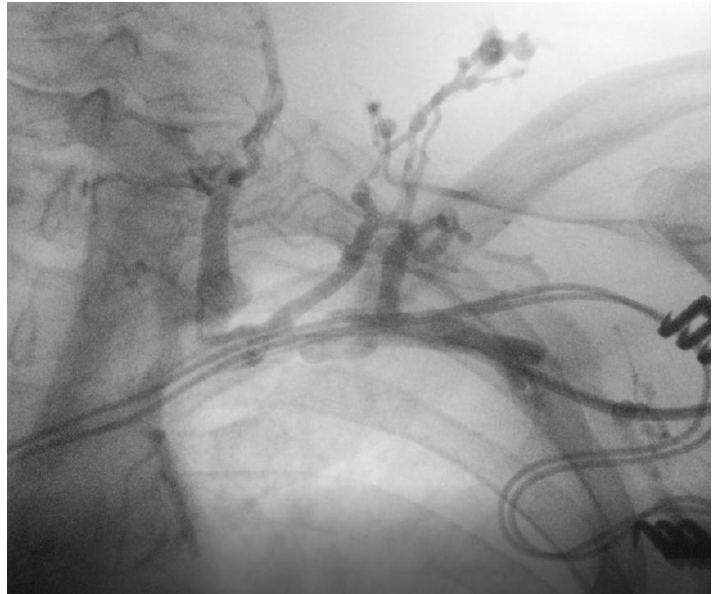
Figure 5. Occlusion of the left subclavian vein, with collateral circulation.